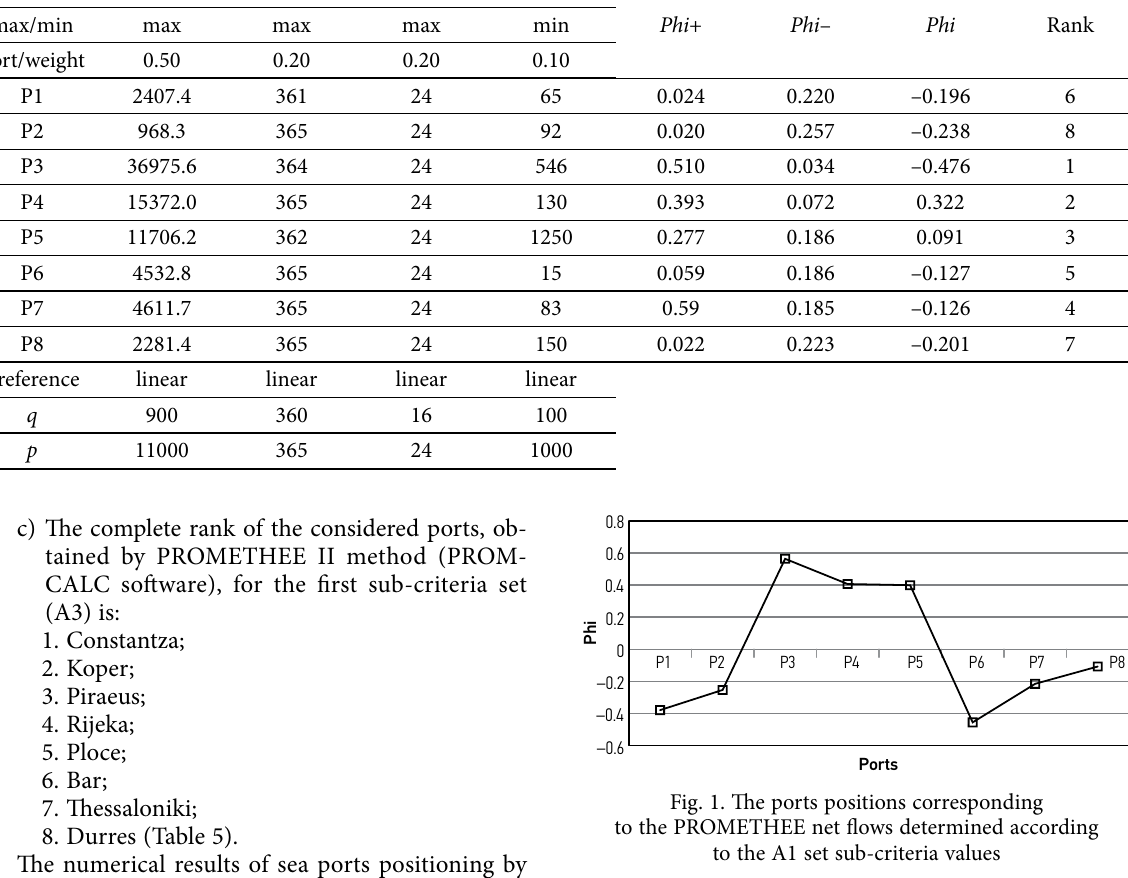
Table 5. PROMETHE II complete rank of the ports for A3 sub-criteria set Criteria